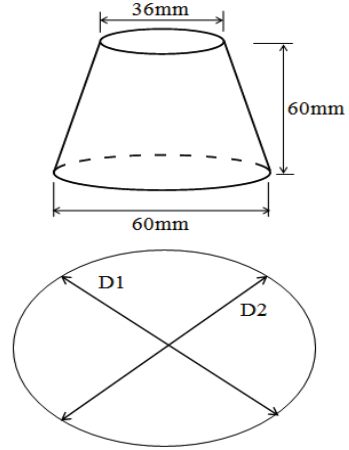
Figure 1. Mini-cone slump test.